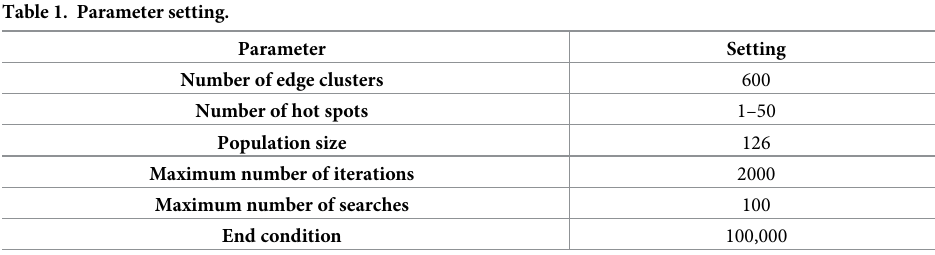
Table 1. Parameter setting.